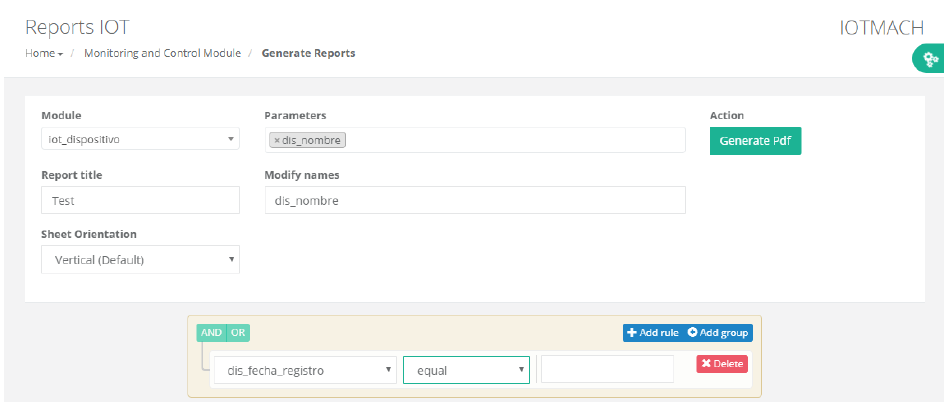
Figure 25. Report